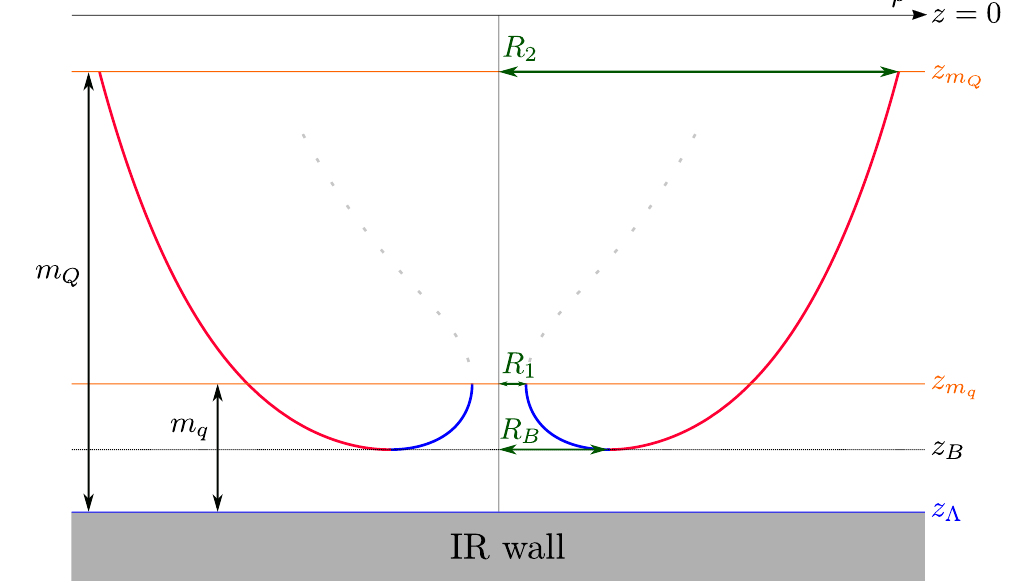
Figure 7 . Slice of a generic double loop solution ( II) for (cid:30) = const. The labels z m the positions of two D8-branes and also specify the masses of the original (outer) quarks m Q and pair-produced (inner) quarks m q